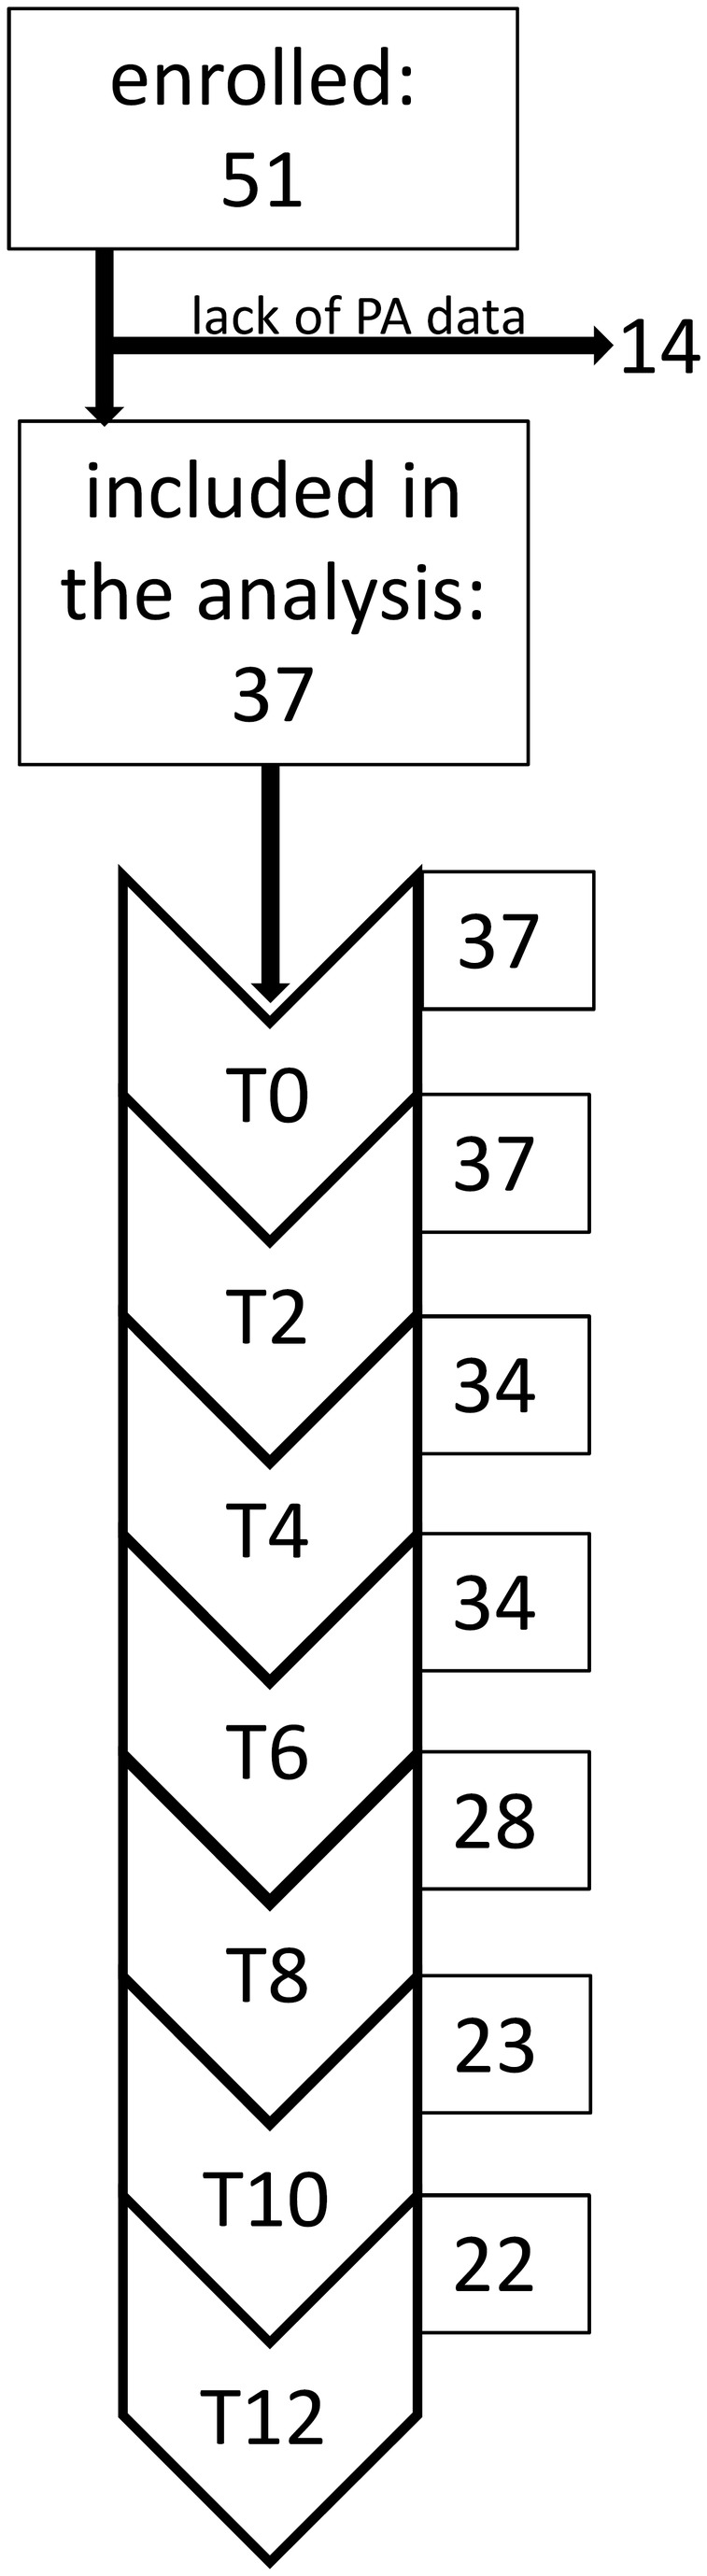
Timeframe of the study.The diagram shows the number of patients in the study at each data measurement point between enrolment, initial assessment (T0), and maximal duration of treatment (T12).